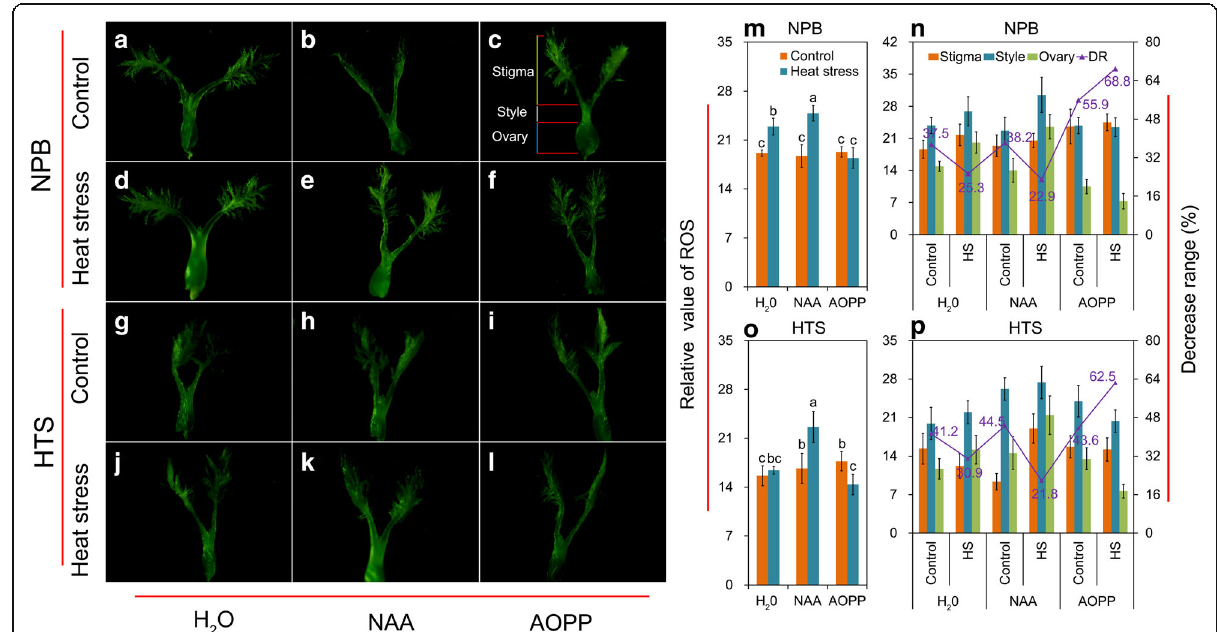
Fig. 4 The ROS level in the pistil under heat stress sprayed with NAA or AOPP. a - l the fluorescent images of pistil in NPB ( a - f ) and HTS ( g - l ) under natural and heat stress conditions; m and o show the average ROS levels, under heat-stress and natural conditions, in the NPB pistil and HTS pistil, respectively; n and p show the relative ROS levels, under heat stress and natural conditions, in the stigma, style and ovary of NPB and HTS, respectively. The levels of ROS in the three components of the pistil, the stigma, style and ovary, were found to be different. Vertical bars denote the standard deviation ( n = 10). Different letters indicate significant differences between control and heat-stress treatments ( P < 0.05)